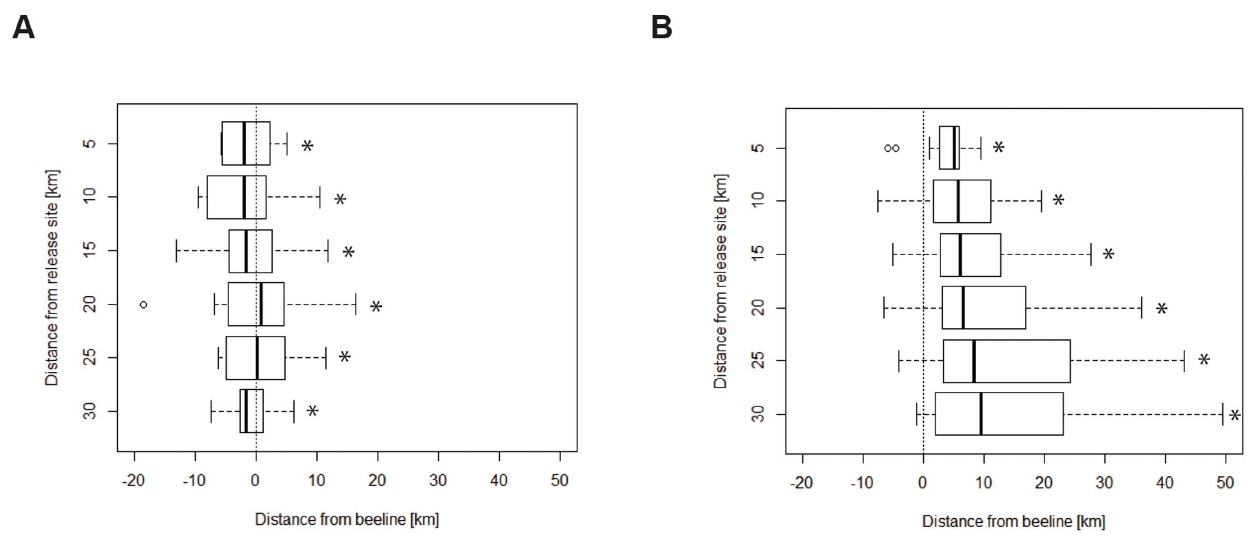
Figure 4. Pigeons from the two lofts maintain different flight directions. (A) Distances of the Z-pigeons from the beeline at 5 km steps. (B) Distances of the S-pigeons from the beeline at 5 km steps. Points easterly of the beeline R-H correspond to positive values of the x-axis, whereas points westerly of the beeline R-H correspond to negative values. The box ranges show the upper and lower quartile with the median, and whiskers extend to the most extreme data point no more than 1,5 6 the interquartile range. Points outside the range are outliers. The stars indicate significant differences between the Z- and the S-pigeons (t-test, p , 0.05 for all).